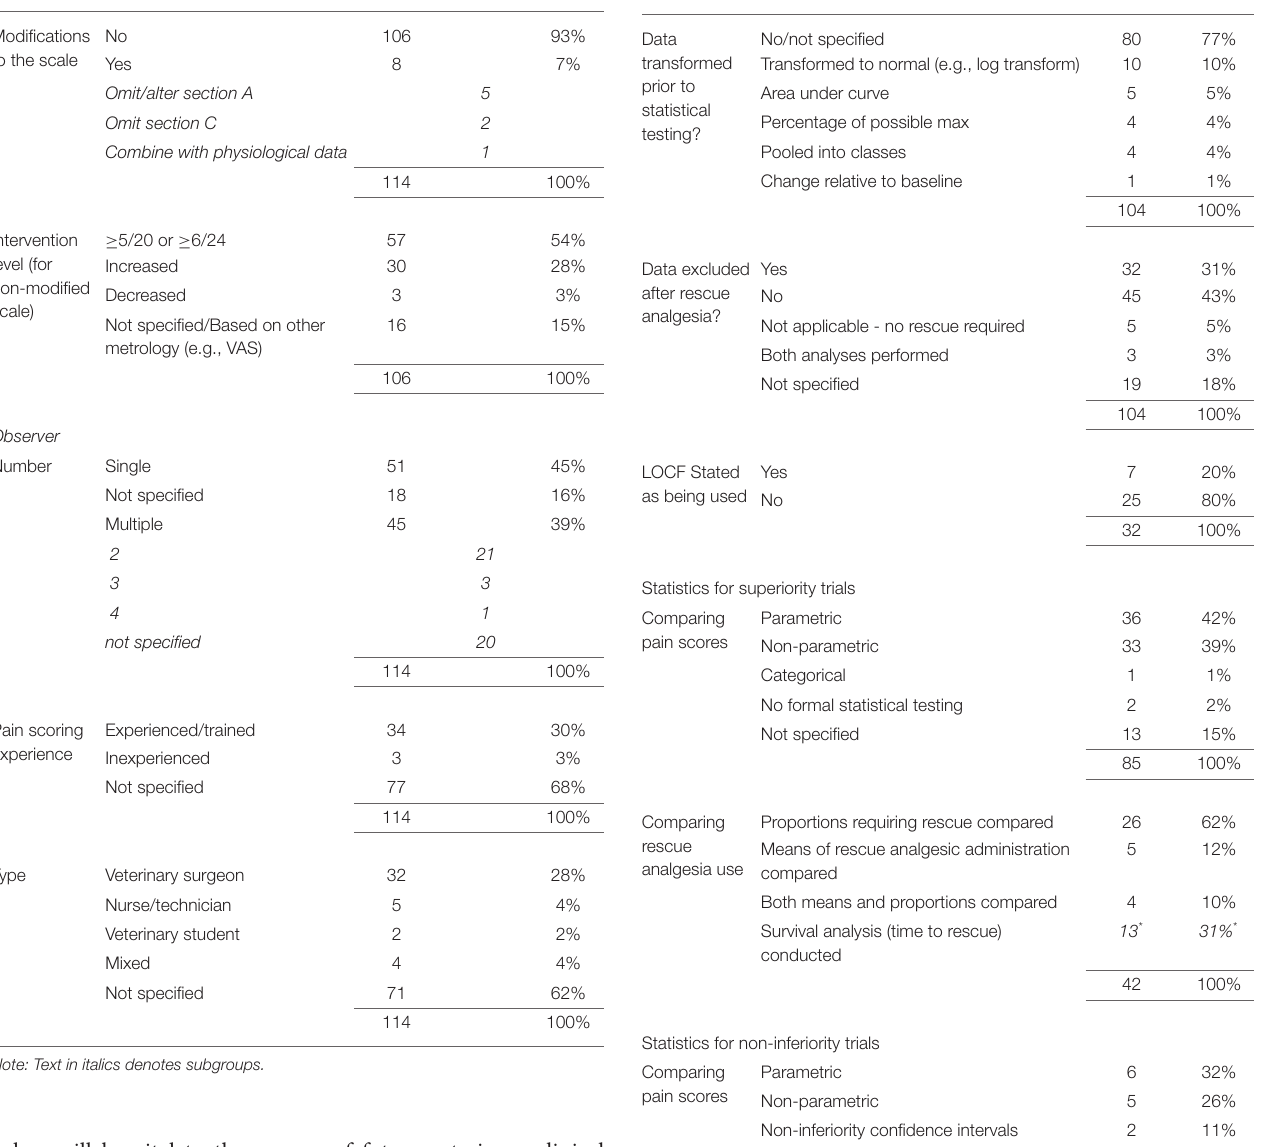
TABLE 2 | Variables from publications in the review describing how the CMPS-SF was used. Variable